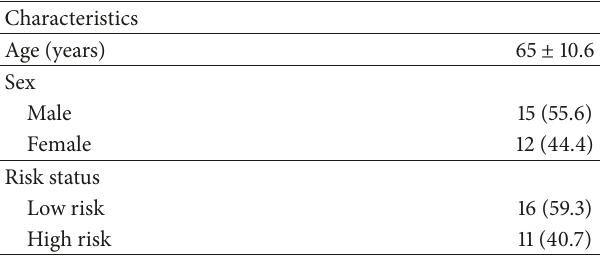
Table 1: Characteristics of the study patients (n =